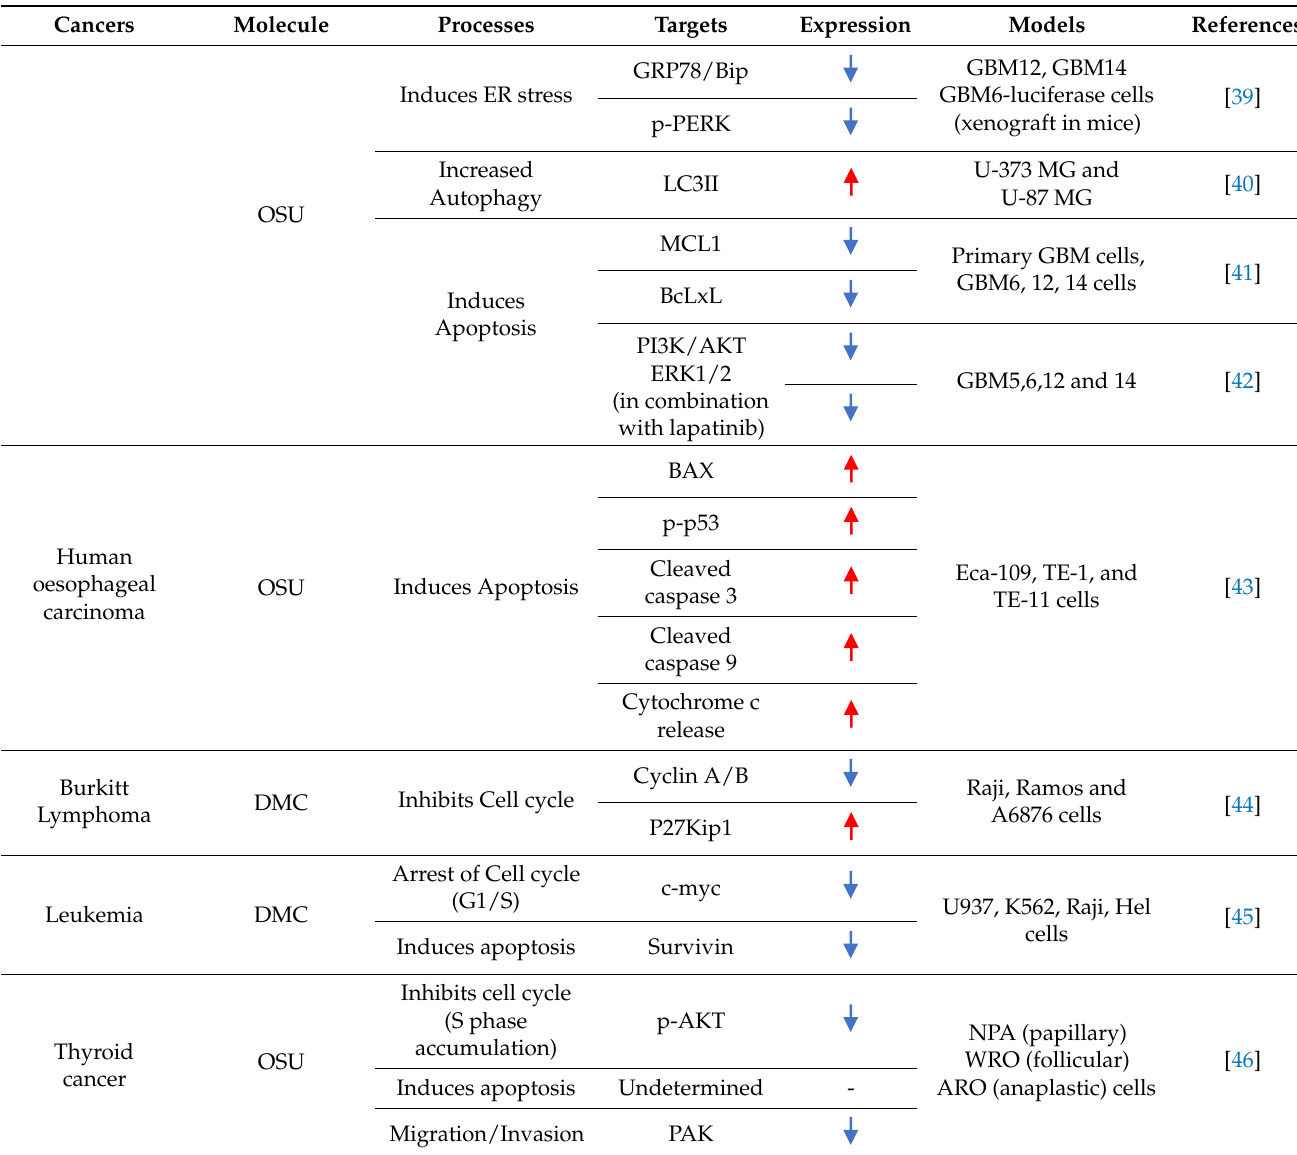
Table 1. Cont. Table 1. Impact of DMC and OSU-03012 in cancers. Table 1. Impact of DMC and OSU-03012 in cancers.